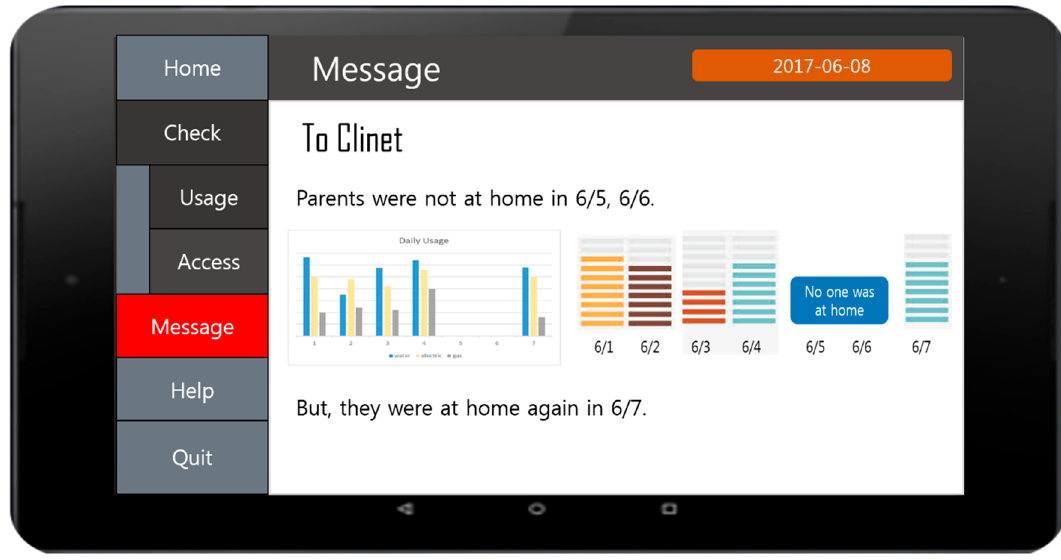
Figure 18. The Relief Message Transmission User Interface.